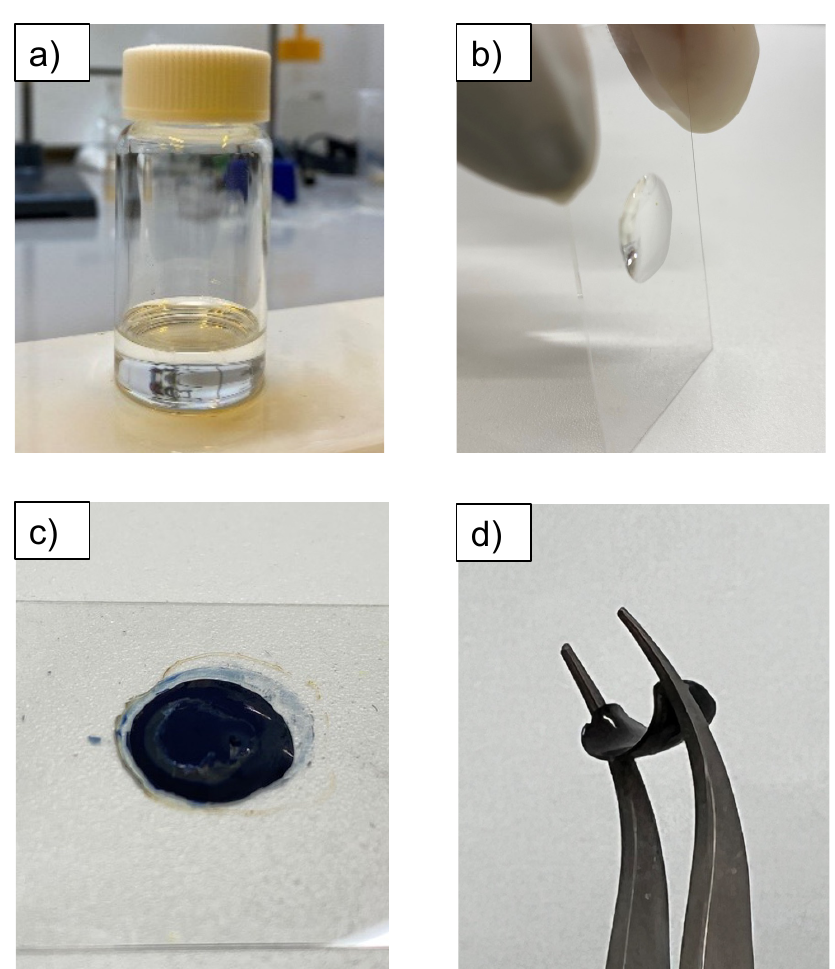
Figure 5. Photographs of the uncured resin containing EDOT ( a ); resin cured by photopolymerization ( b ); resin after oxidation polymerization ( c ); and fabricated flexible sample bent with tweezers ( d ). The diameter of the cured droplet was 20 mm.